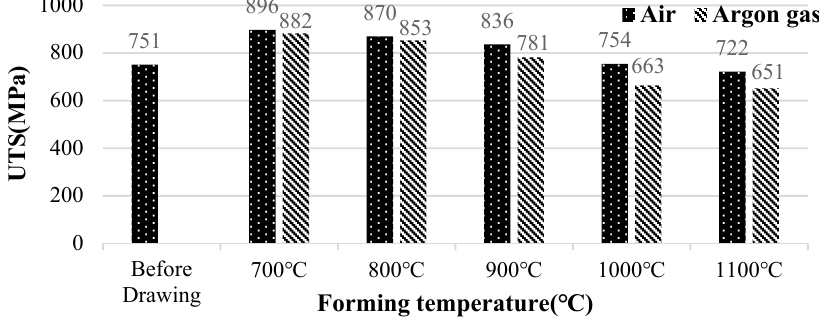
Figure 7. Comparisons of ultimate tensile strength of drawn wires in air and argon gas.